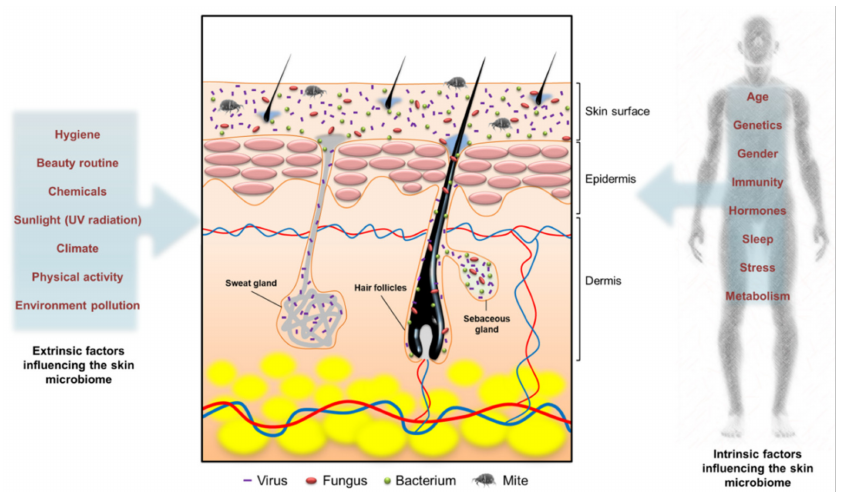
Figure 1. The intrinsic and extrinsic factors influencing the microbiome on the skin. S. epidermidis is regarded as the primary microorganism colonizer of the skin. This species is a skin commensal but can also be an opportunistic pathogen in barrier- disintegrated or immunocompromised skin [29]. The pathogenic nature of S. epidermidis depends upon the disease condition and the microbiome. In patients with atopic dermatitis (AD), a correlation has been found between symptom deterioration and the S. epidermidis quantity [30]. Virulent strains of S. epidermidis can produce biofilms to protect them from the host’s immune system, thereby increasing the resistance level. S. aureus is one of the main biofilm-forming pathogens found on the skin. This strain is an opportunistic microbe that can generate abscesses, cellulitis, folliculitis, and lymphangitis [31]. The drug-resistant S. aureus has a high probability of establishing a biofilm for developing into persistent and recurrent infections [9]. Multidrug-resistant S. aureus , especially methicillin-resistant S. aureus (MRSA), is a frequent cause of recurrent skin and soft tissue infections. MRSA repre- sents 26% of all infections induced by S. aureus [32]. C. acnes is a gram-positive